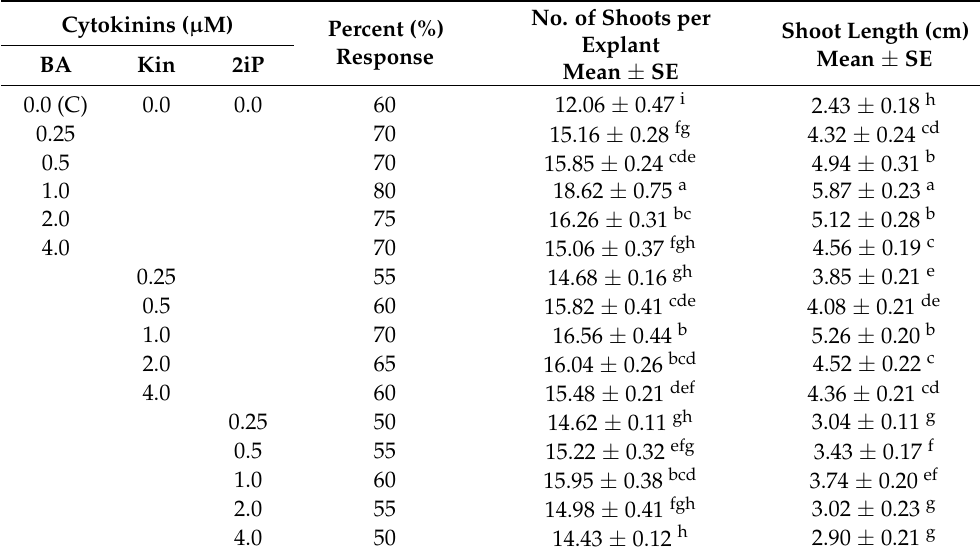
Table 3. Effect of different concentrations of cytokinins on 5.0 µ M TDZ-exposed node explants of L. speciosa for shoot multiplication and elongation after 8 weeks of culture.